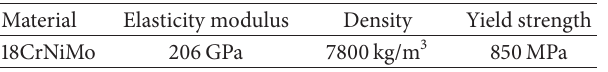
Table 3: Material parameters of one-level reducer gear.